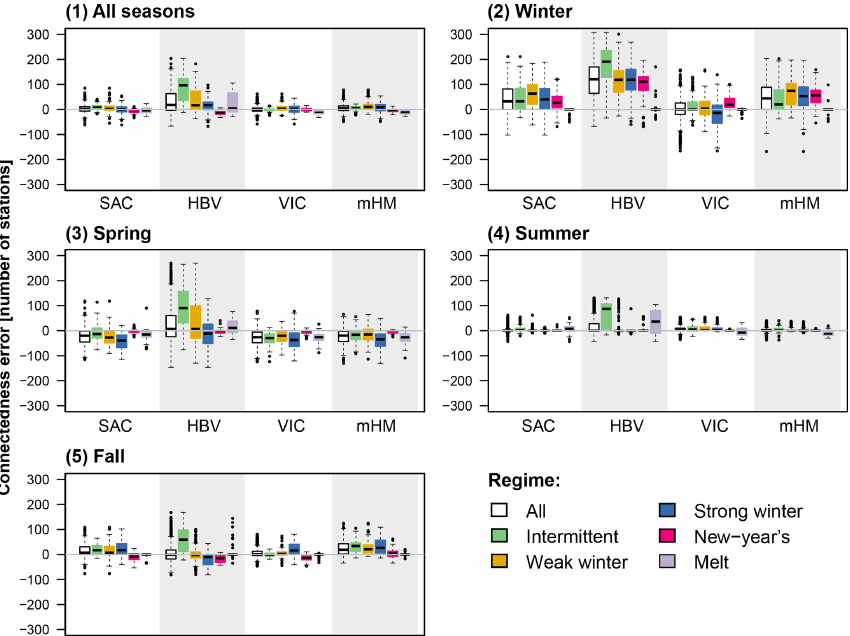
Figure 4. Overall (1) and seasonal (2–5) errors in flood connectedness (simulated minus observed connectedness), i.e., number of catchments a catchment is sharing at least 1% of the total number of flood events with, for the four models SAC, HBV, VIC, and mHM over all regimes and per regime: intermittent (114 catchments), weak winter (108), strong winter (176), New Year’s (50), and melt